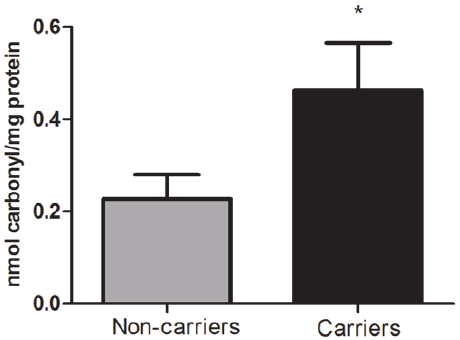
Figure 3. Carbonyl content in plasma. Carbonyl content (mean 6 S.E.M) in plasma from p.R337H mutation carriers (n=11) and non- carriers (n=14). (*) P , 0.05 (Mann Whitney test).